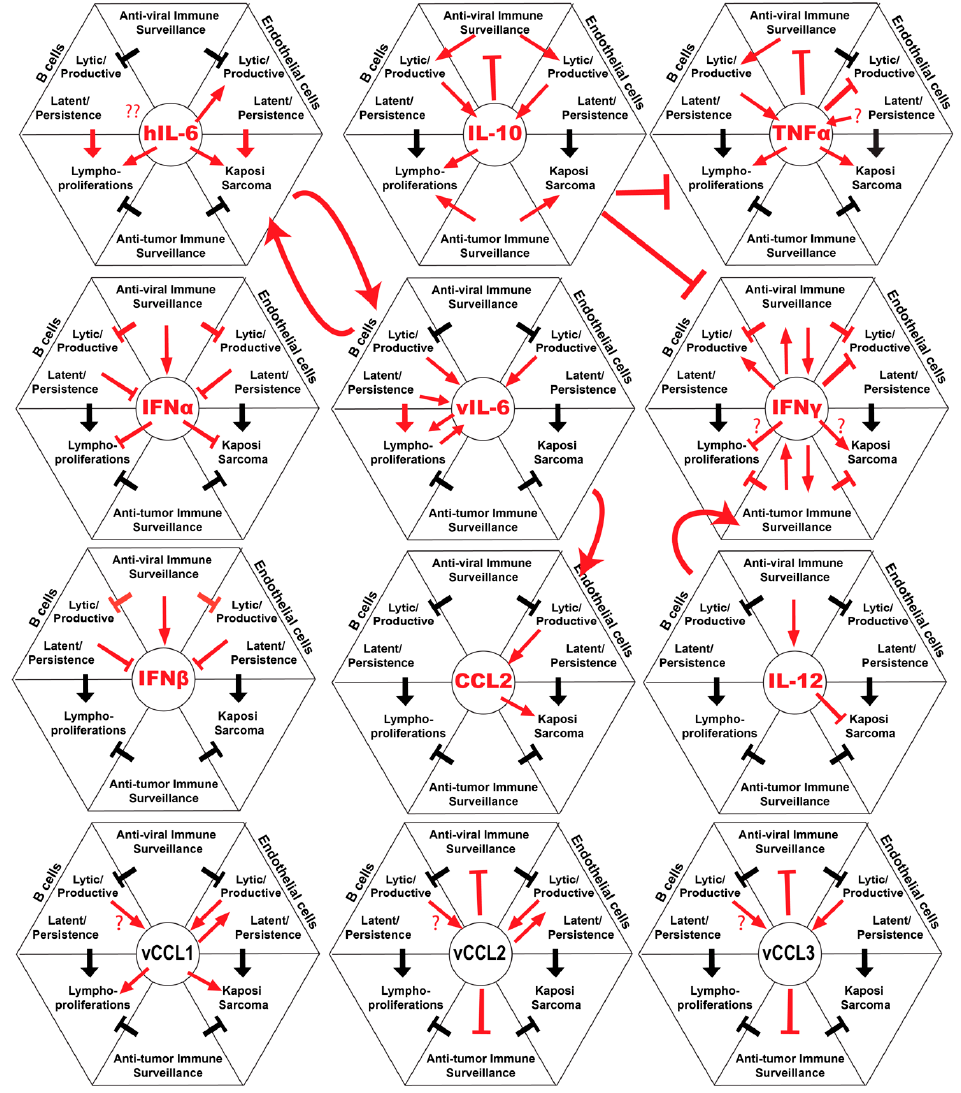
Figure 1. Summary of host and viral cytokines and their interactions with Kaposi’s sarcoma-associated herpesvirus (KSHV) infection, immunity and tumor progression.